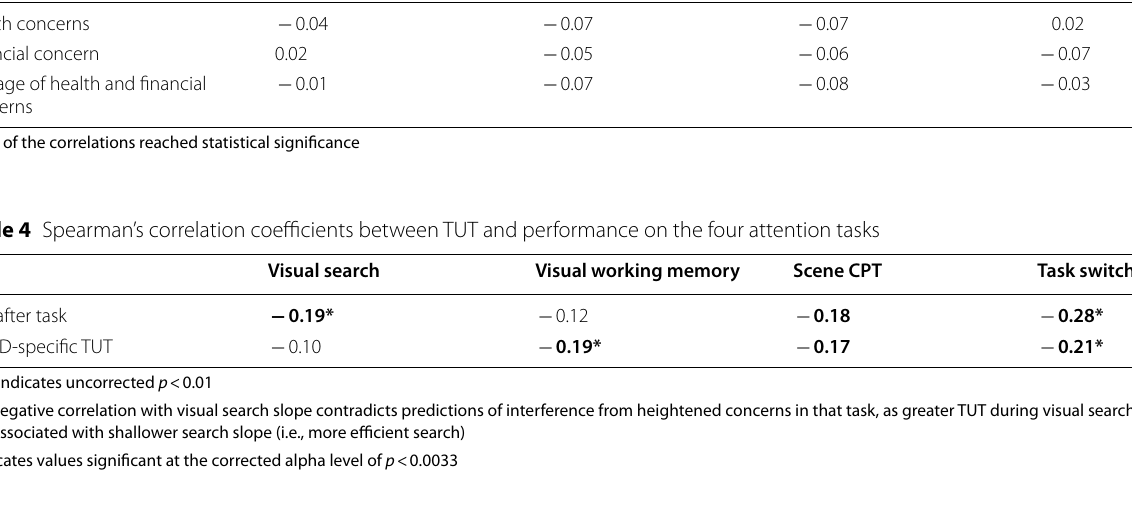
Table 3 Pearson’s correlation coefficients between survey-indicated concerns and performance on the four attention tasks Visual search Visual working memory